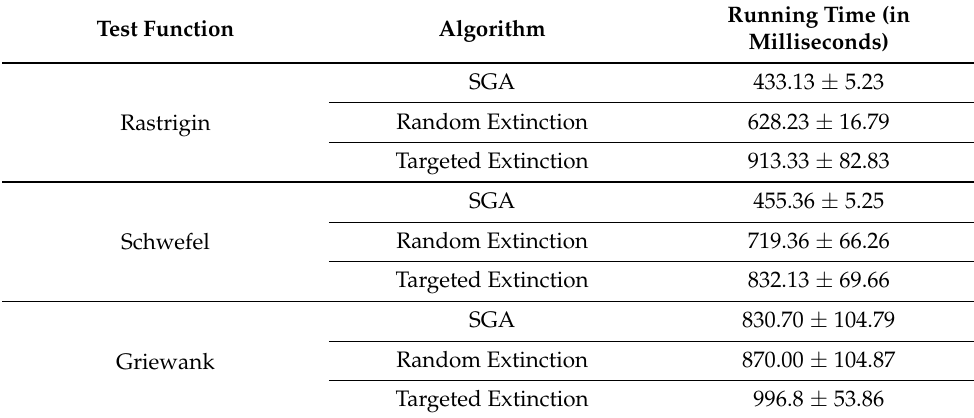
Table 2. Overall running time (in milliseconds) of SGA, and SDEP-GA with random and targeted extinction; 95% confidence interval is presented after ±